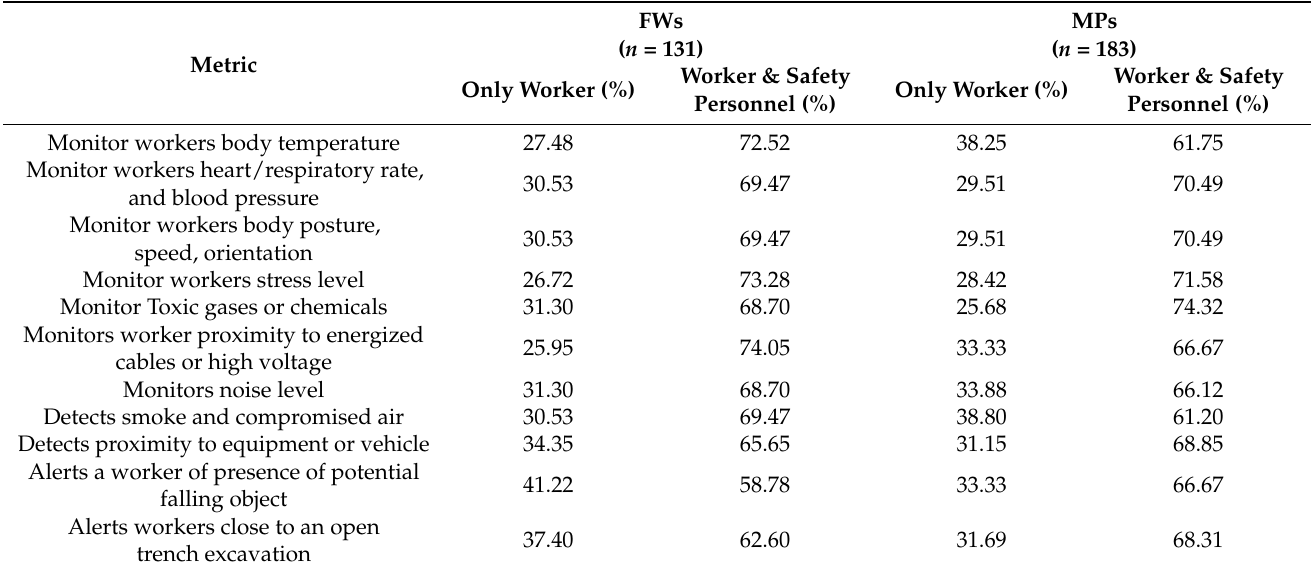
Table 5. Workers’ Data Sharing